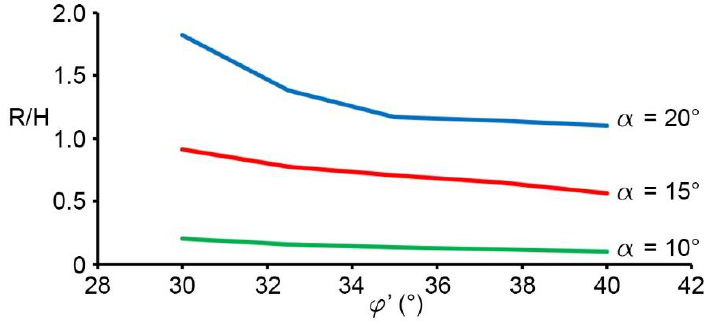
Figure 13. Dimensionless run- out distance, R/H, versus φ’, for α = 20° and some values of Δu.